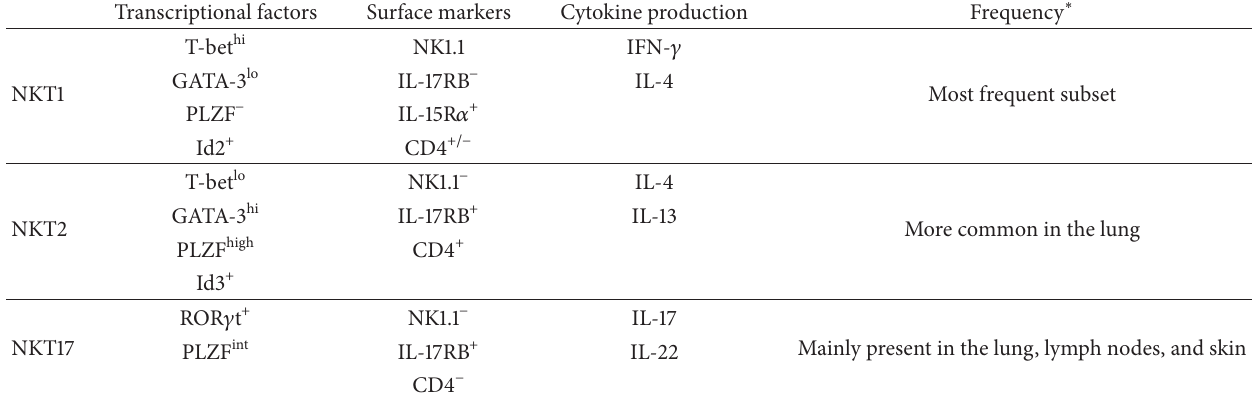
Table 2: Main iNKT cell subsets in mice: transcriptional programs, surface markers, cytokine production, and